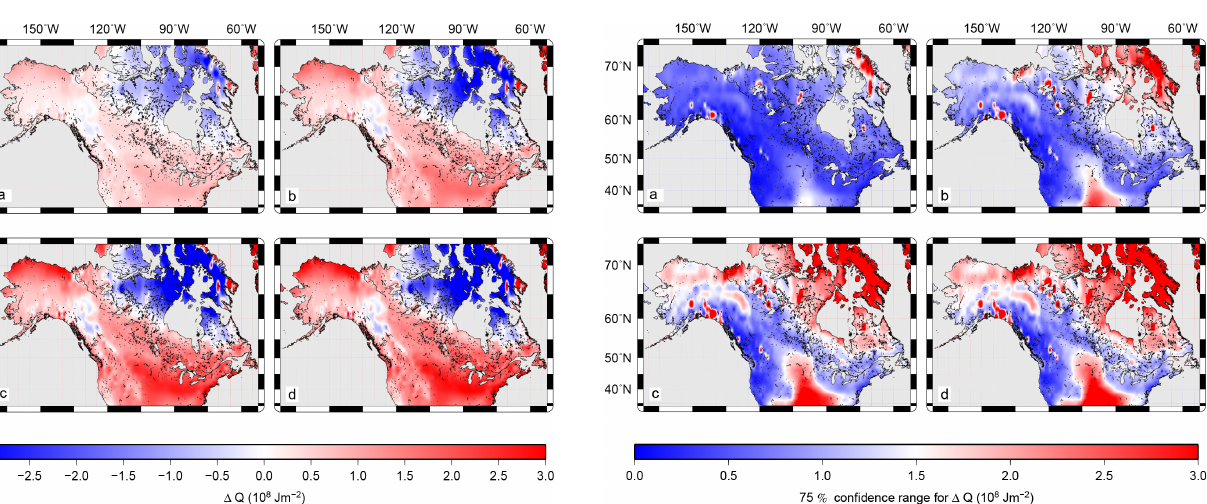
Figure 8. Heat content contribution per unit area from the LGC. Shown are the estimates of the contribution to the subsurface ther- mal energy from long-term climatic changes. Results are shown for depth ranges of (a) 0–80, (b) 0–160, (c) 0–320, and (d) 0–600m.